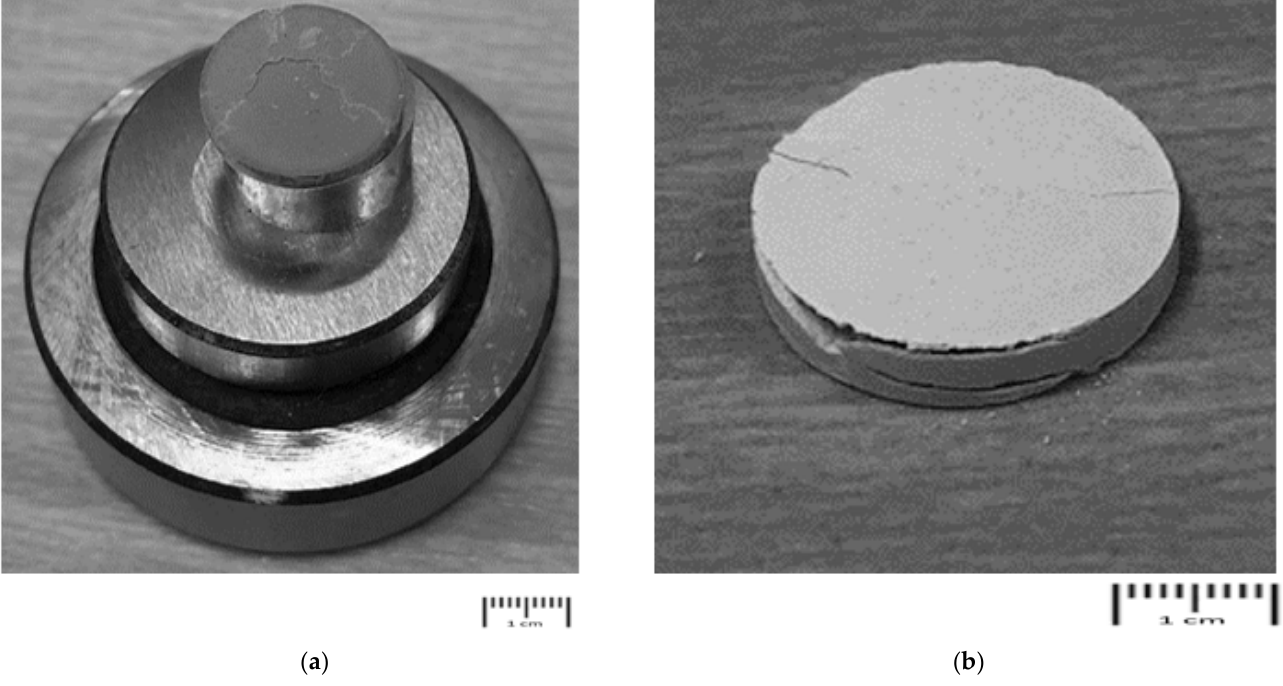
Figure 5. Fractured and incoherent pellets produced without binders. ( a ) Mittersill ore pellet produced using evaporation drying technique. ( b ) Penouta ore pellet produced using evaporation drying